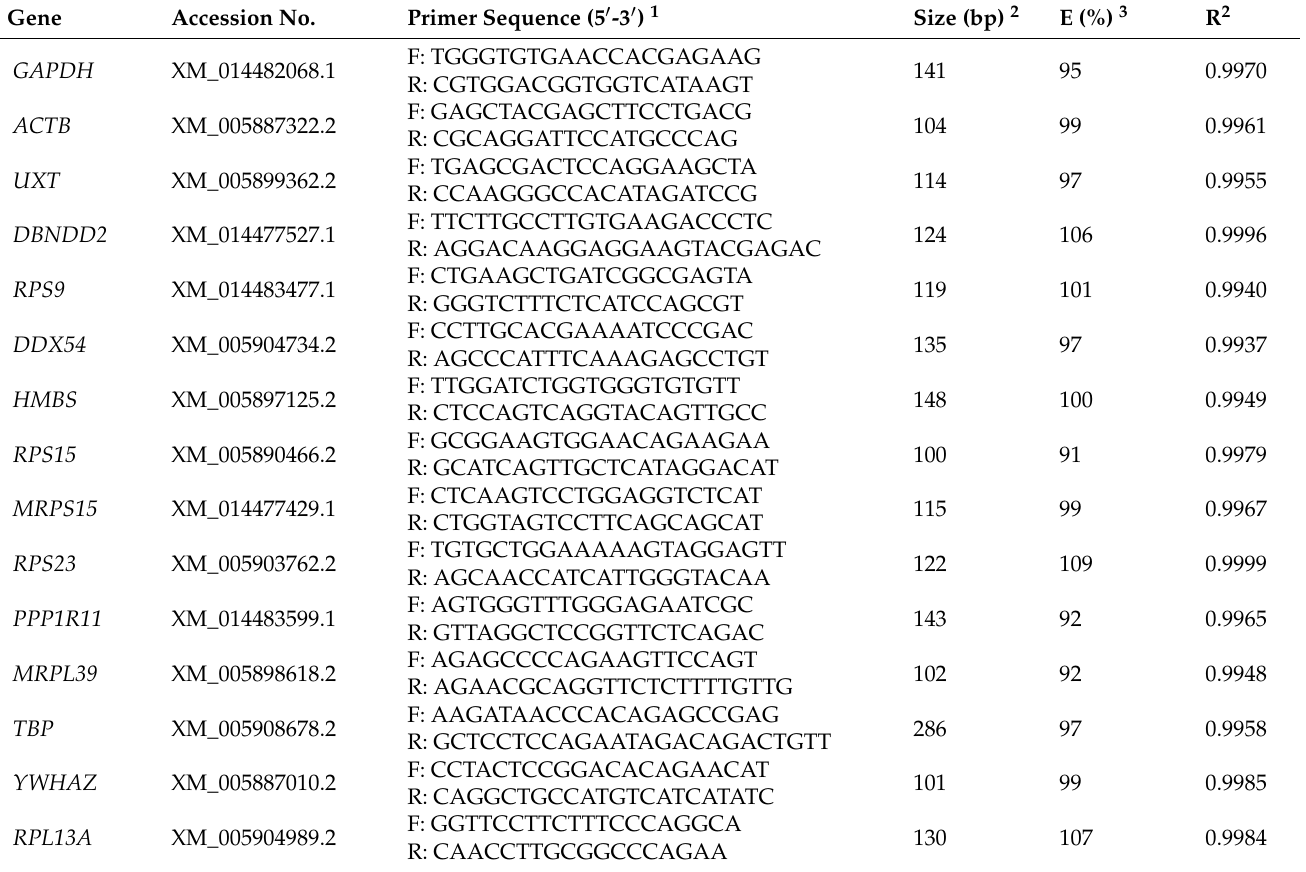
Table 1. Candidate reference genes and primer pairs